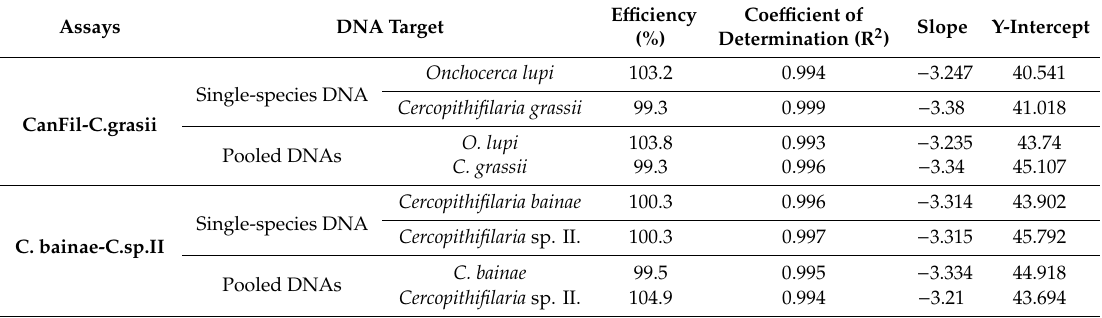
Single Species and Pooled DNAs.